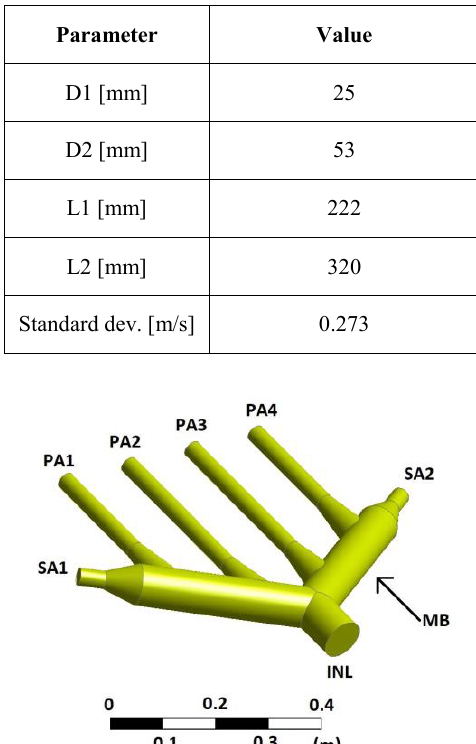
Table 2. The values of input parameters for candidate point and the verified values of the output parameter